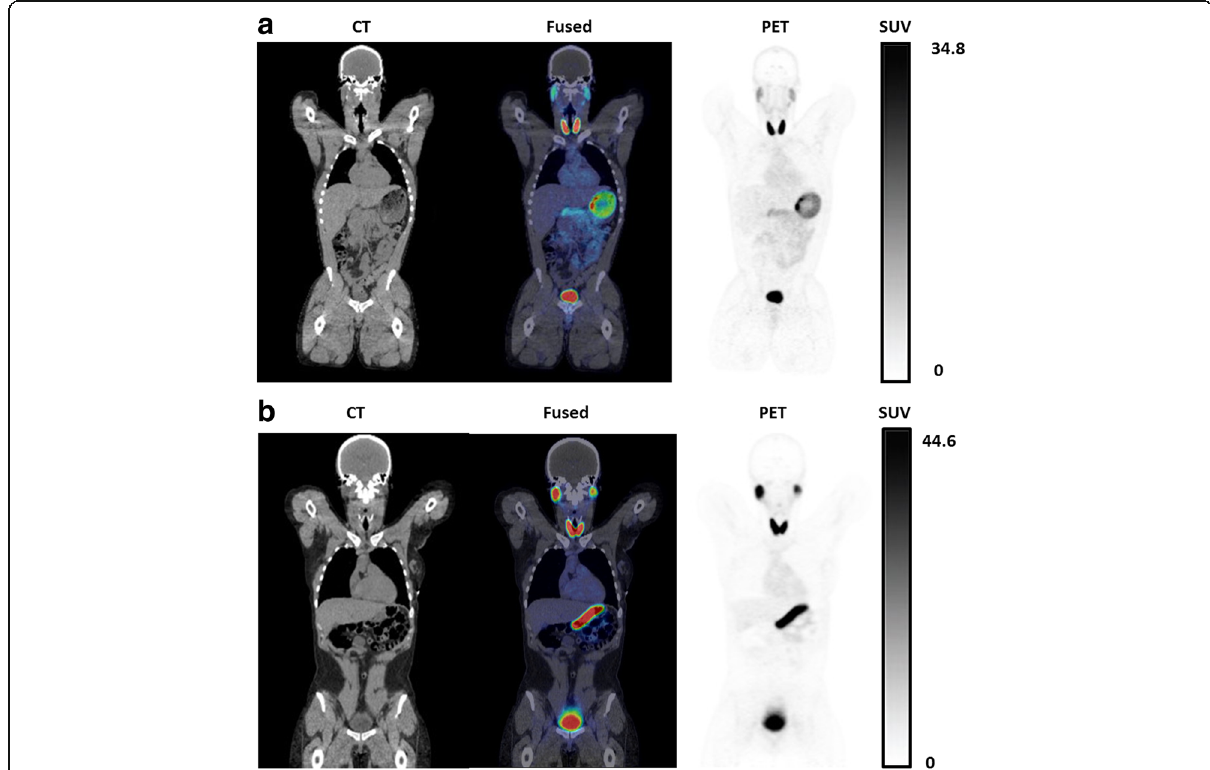
Fig. 3 Coronal PET/CT images of 18 F-TFB in healthy male ( a ) and female ( b ) participants at 2 h post-injection. Physiologic distribution of 18 F-TFB is seen in the thyroid, salivary glands, stomach, and intestines. Prominent excretion of radioactivity is seen in the urinary bladder